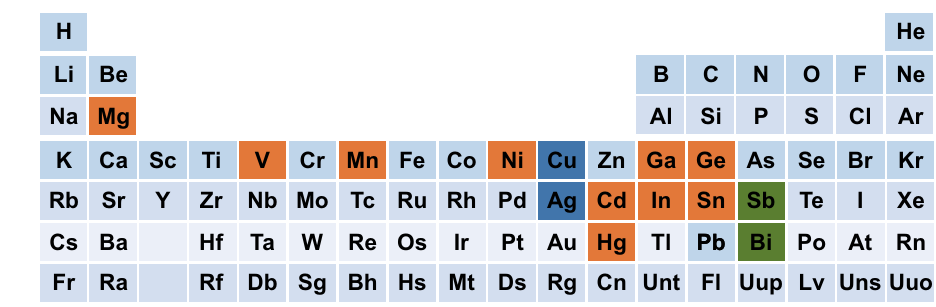
Fig. 1 Potential elements to substitute Pb. The orange shading on the periodic table marks the screened elements by Filip et al. that can replace Pb. The green shading of the VA group heterovalent elements and the blue shading of transition metal elements have also been calculated or proved to substitute Pb. (Color figure